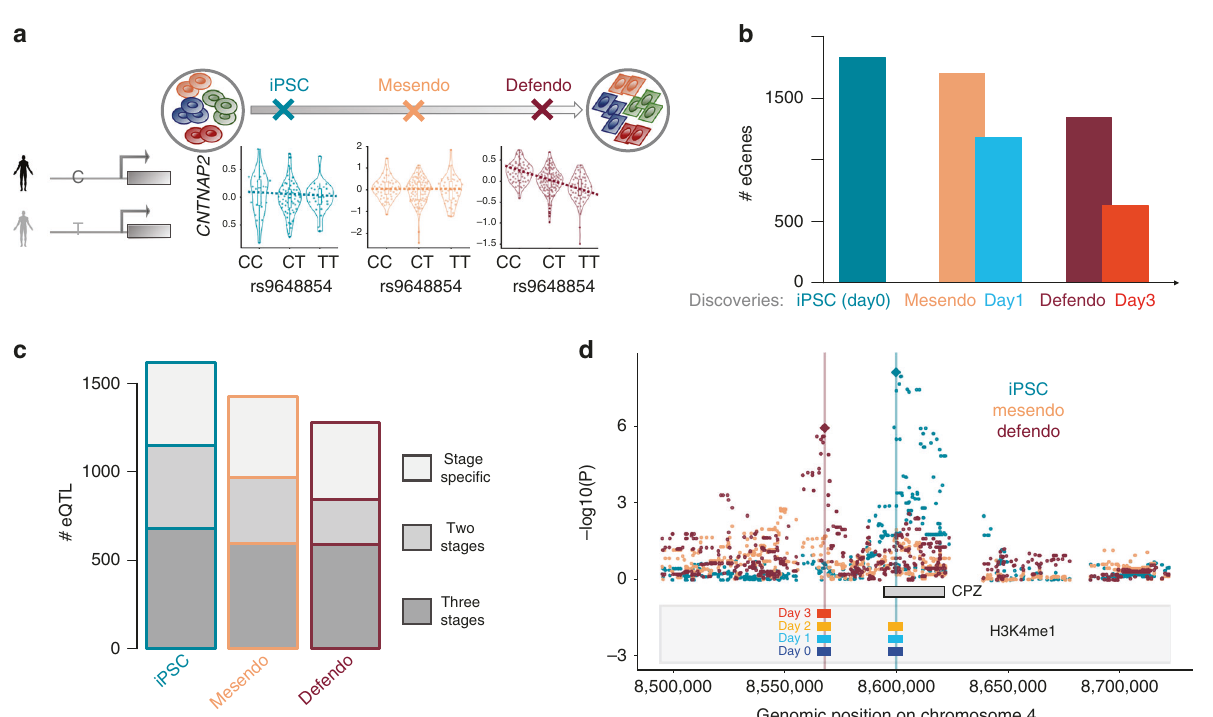
Fig. 2 Mapping single-cell eQTL in each developmental stage. a Illustration of the single cell eQTL mapping strategy at different stages of differentiation. Shown is an example of an eQTL that is speci fi c to the de fi nitive endoderm (defendo) stage. Boxplots of gene expression strati fi ed by the allelic state of rs9648854 at each stage, showing an association between rs9648854 and CNTNAP2 expression at the defendo stage, but not at earlier stages. https:// github.com/ebiwd/EBI-Icon-fonts by EBI Web Development is licensed under CC BY 4.0. b Comparison of eQTL mapping using different strata of all cells. Stage de fi nition based on pseudotime ordering increases the number of detectable eQTL, compared to using the corresponding time point of collection. Bars represent number of eGenes (genes with at least one eQTL, at FDR < 10%). c Proportion of eQTL that are speci fi c to a single stage, shared across two stages, or observed across all stages (sharing de fi ned as a lead eQTL variant at one stage with nominal signi fi cant effects P < 0.05 and consistent direction at another stage). d A lead switching event consistent with epigenetic remodelling. The overlap of H3K4me1 with the eQTL SNPs across differentiation time points is indicated by the coloured